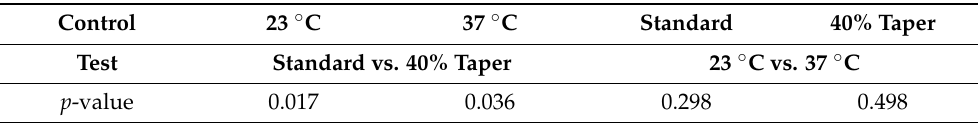
Table 3. One-tailed t-test for evaluation of tapered-strut and temperature effects.